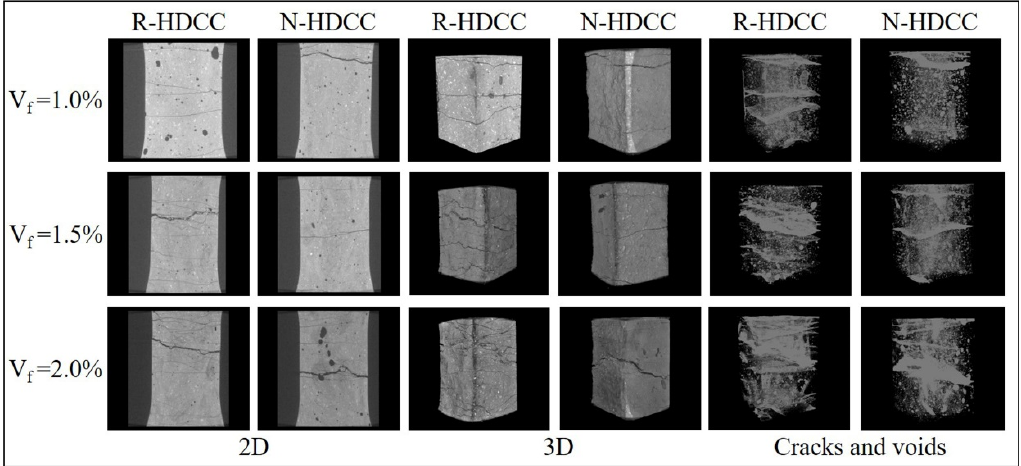
Figure 13. Dog-bone specimens after axial tensile test.